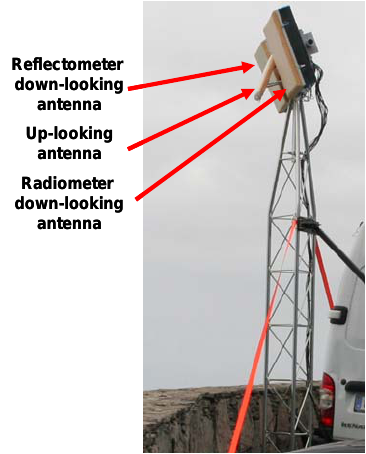
Figure 9. griPAU instrument mounted on a 6 m tower with automatic antenna positioner, during the ALBATROSS 2009 field experiment in Gran Canaria (Canary Islands, Spain).